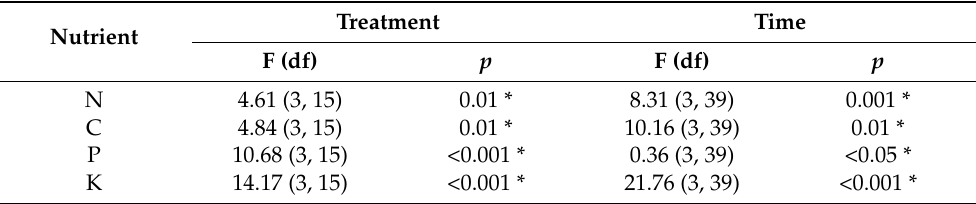
Table 2. Overall main effects for treatment and time (* denotes significance).